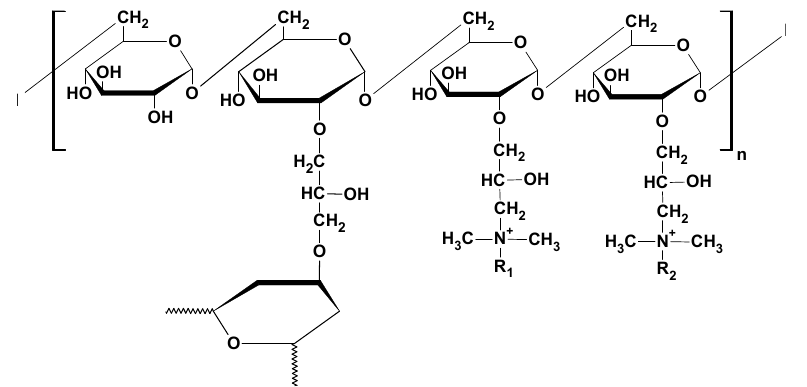
Figure 1. Dextran-based hydrogels (R 1 = dodecyl or hexadecyl; R 2 = ethyl). Dextran-based amphiphilic gels with pendant quaternary ammonium groups were studied as potential anticholesteremic agents or efficient dye adsorbents. The occurrence of two types of pendant quaternary ammonium groups in gel structure enhanced the above-mentioned properties. [101–104]. The morphology of dextran cationic hydrogels was analyzed by scanning electron microscopy. The polymeric microparticles, observed in dry state, were perfectly spherical, having a diameter between 100–220 µ m (Figure 2a). These hydrogels are not porous in dry state (Figure 2a,b), but they have a high water uptake capacity (swelling porosity) which favors the diffusion of adsorbate molecules inside the swollen network of the microspheres.